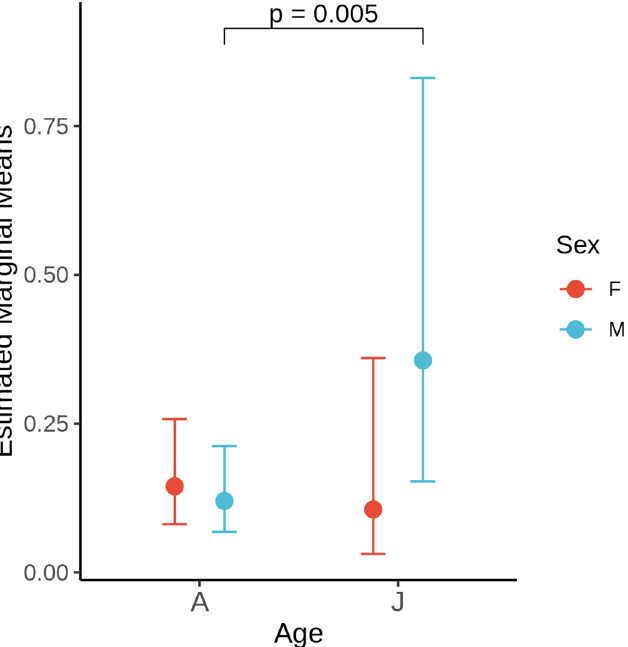
Figure 3. Estimated marginal means from a GLMM comparing the effects of host demographics on the isolation of bacterial strains with Pd inhibition. M = Male, A = Adult, VJ = Juvenile. P values have been adjusted